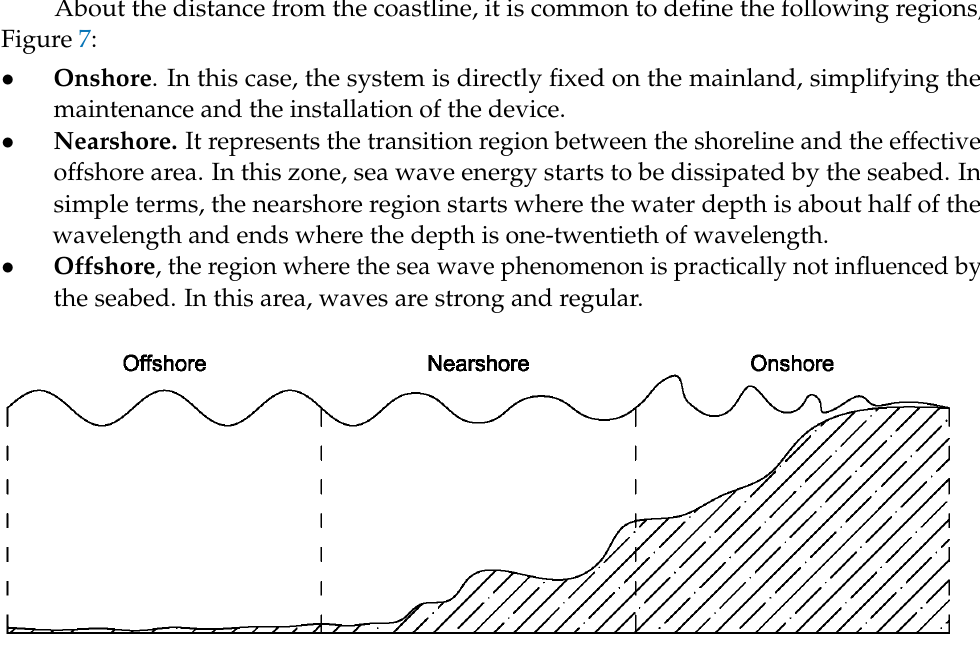
Figure 6. Global wave power GIS map.